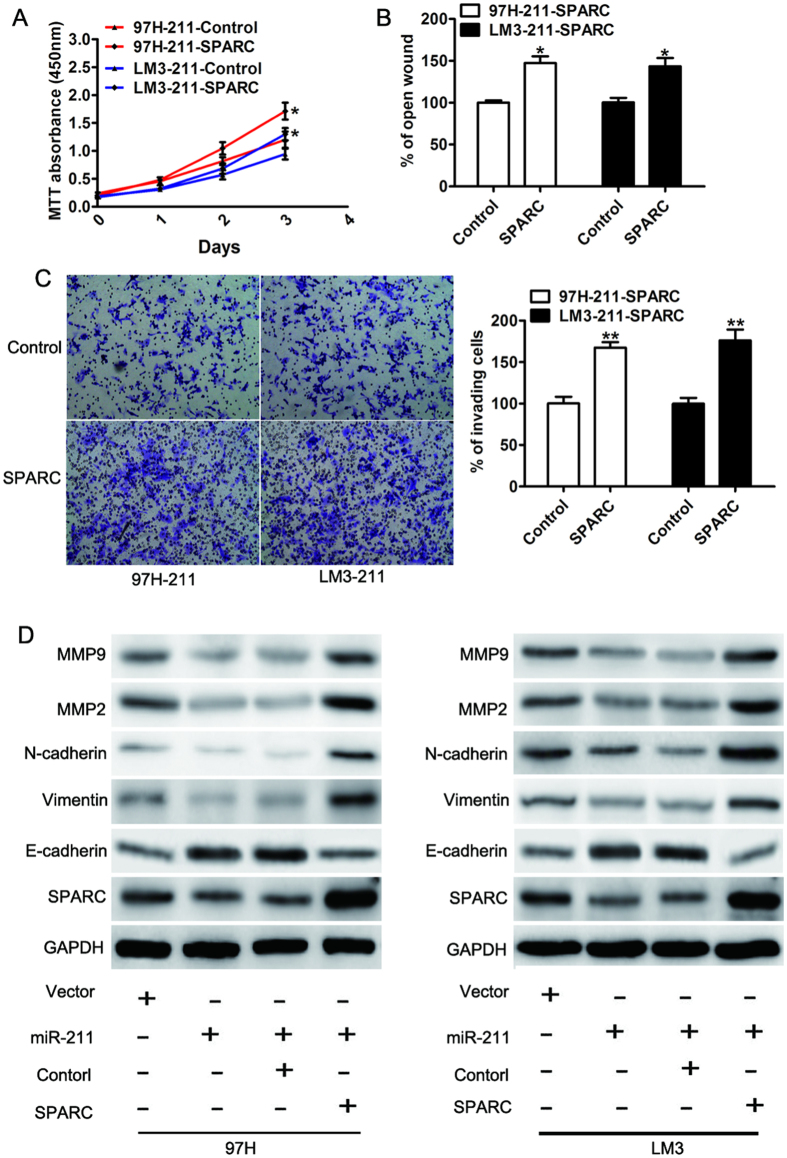
SPARC was functionally involved in the miR-211-mediated proliferation and invasion of HCC cells.(A) MTT assay, (B) Wound healing assay and (C) invasion assay were analyzed in 97H-miR-211 and LM3-miR-211 cells transfected with control (control) or SPARC. (D) Total lysates from the indicated cells with different treatments were analyzed with relative antibodies by WB analysis. GAPDH was used as the loading control.